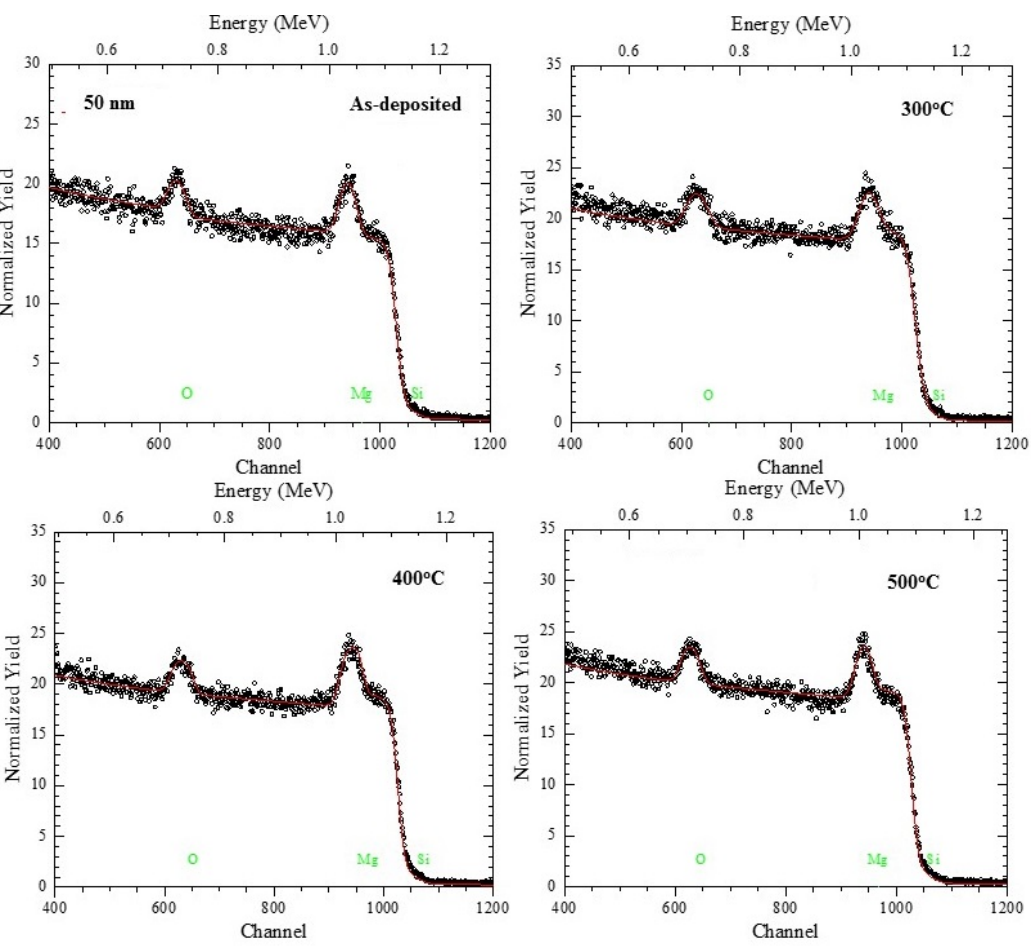
Figure 3. Experimental (open circles) and simulated (red line) RBS spectra of as-deposited thin film of thickness 50 nm annealed at 300, 400 and 500 o C.